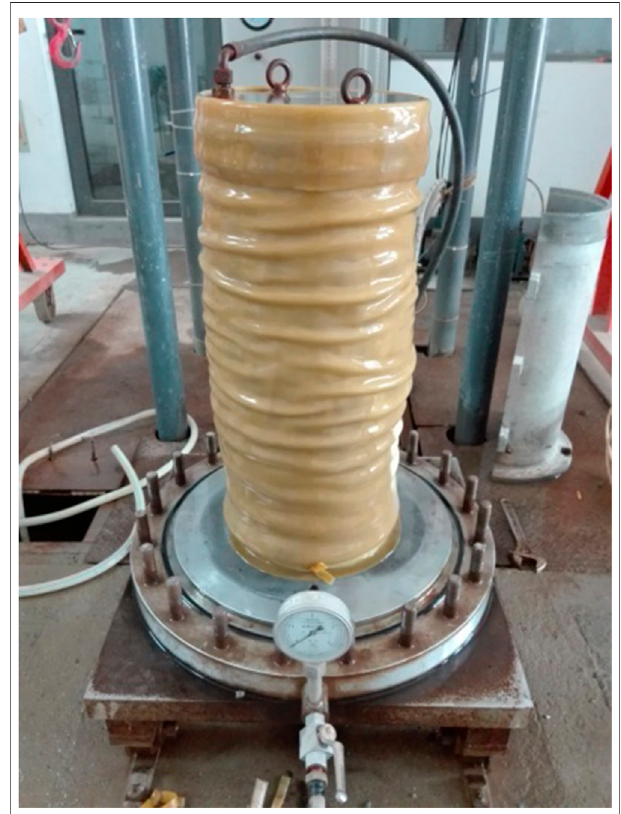
FIGURE 4 | Sample after test.